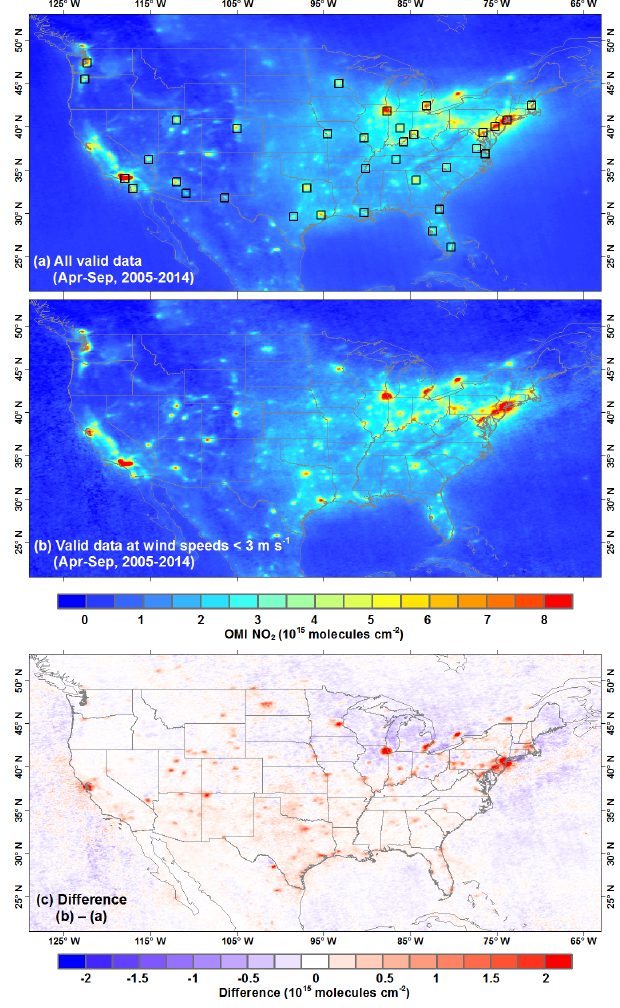
Figure 1. Average summer half-year (i.e., April–September) OMI NO 2 TVCDs over the continental US during 2005–2014: (a) all valid data were used, (b) only valid data with wind speeds <3ms − 1 were used, and (c) the difference between (b) and (a) . Squares in (a) indicate the urban areas selected in this